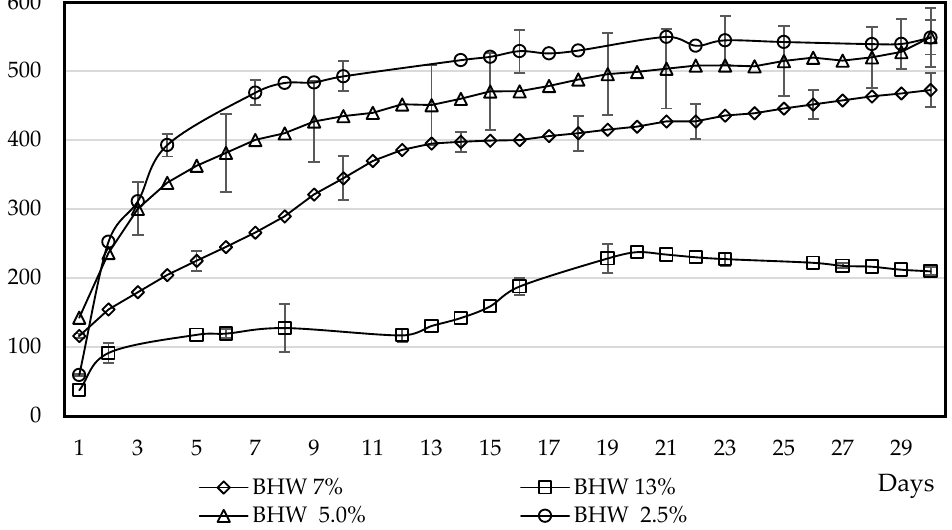
Figure 4. Cumulative methane outcome in 30 days for biomass hydrolysis waste digestion in different VS load from inoculum VS.